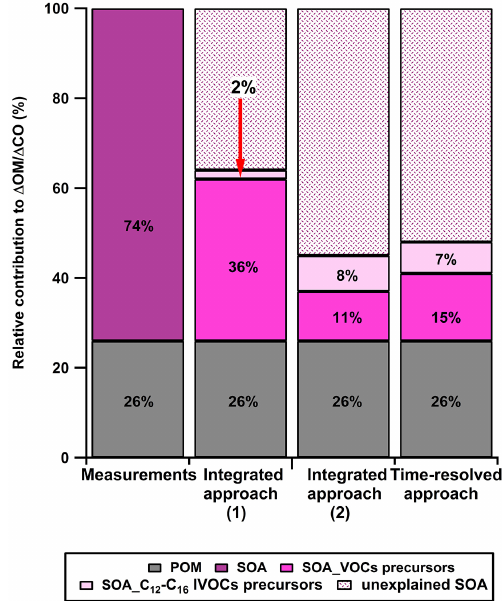
Figure 6. Comparison between the relative contribution to 1 OM /1 CO of measured SOA and SOA estimated from VOCs (SOA_VOCs precursors) and from the C 12 –C 16 IVOCs (SOA_IVOCs precursors), from integrated and time-resolved ap- proaches in suburban Paris during summer 2009. SOA yields of at- mospheric relevancy were used in the integrated approach (1); SOA yields determined under high NO x and high C OA were used in the integrated approach (2). Numbers in the bars correspond to the rela- tive mass concentration (%) explained by each type of organic mat-